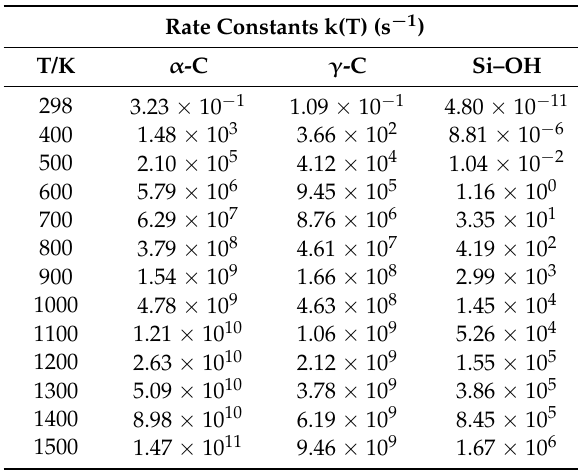
Table 1. Rate Constants k (T) calculated at the B3LYP/6-311G (d, p) level.